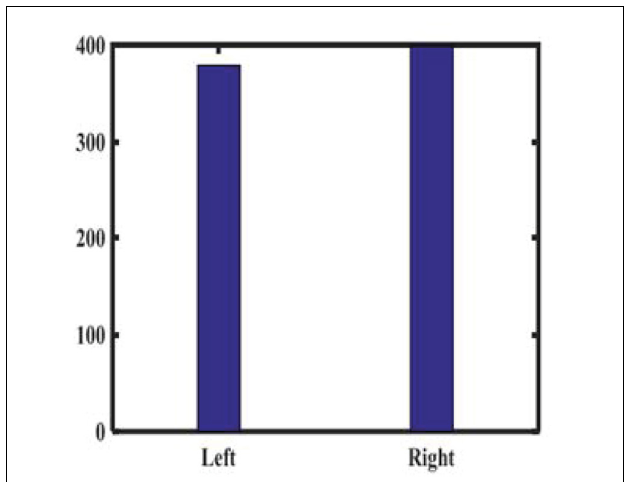
FIGURE 4 | The laterality of the affected eye of uveal melanoma (UM)